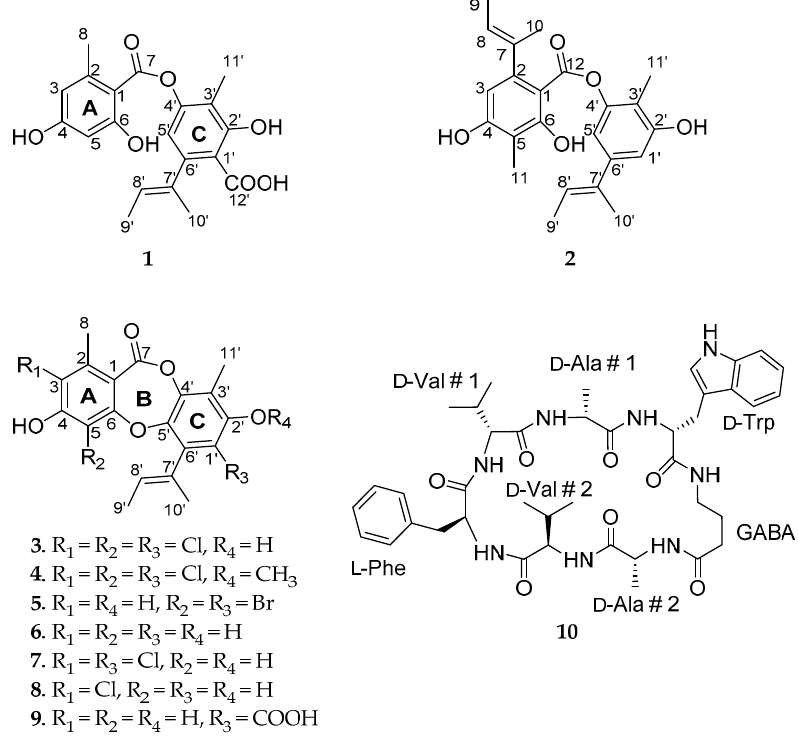
Figure 1. Structures of compounds 1 ‒ 10 .